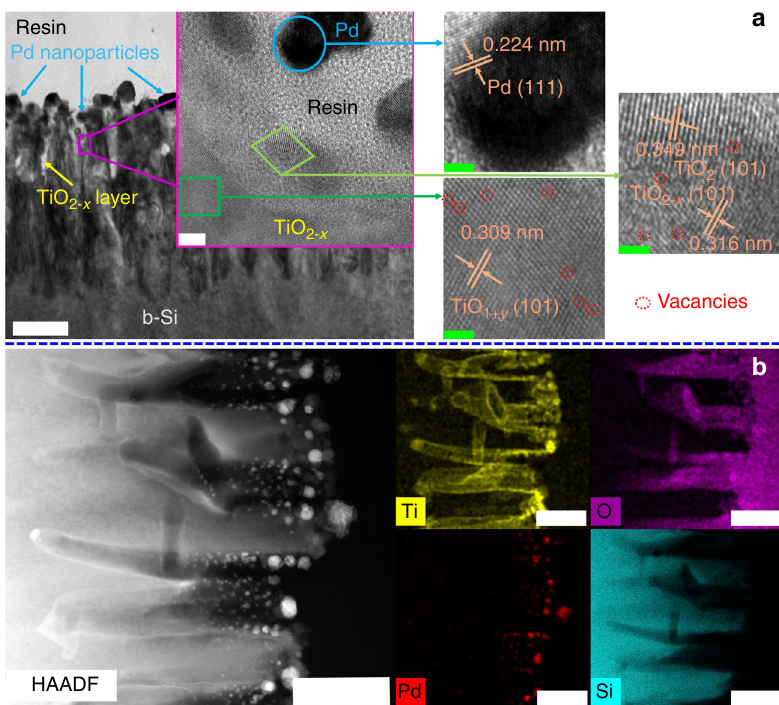
Fig. 3 Microstructure and composition distribution of Pd/b2-TiO 2 /b-Si. a Cross-sectional TEM image and related high-magni fi cation images of Pd/b2- TiO 2 /b-Si. The scale bar label is 200 nm in TEM image. The inset in TEM image is the magni fi cation image of the speci fi ed area by HRTEM with the scale bar label of 5 nm. High-magni fi cation images on the right correspond to the marked area in the inset with the scale bar label of 2 nm. b HADDF-STEM image with matching elemental distribution map for Pd/b2-TiO 2 /b-Si. Ti, O, Pd, and Si are represented as yellow, purple, red, and Cambridge blue, respectively. All the scale bar labels are 200 limiting current density of 25.2 mA cm − 2 . This is lower than ideal photocurrent of ~37.5 mA cm − 2 as calculated (Supplementary Fig. 4).